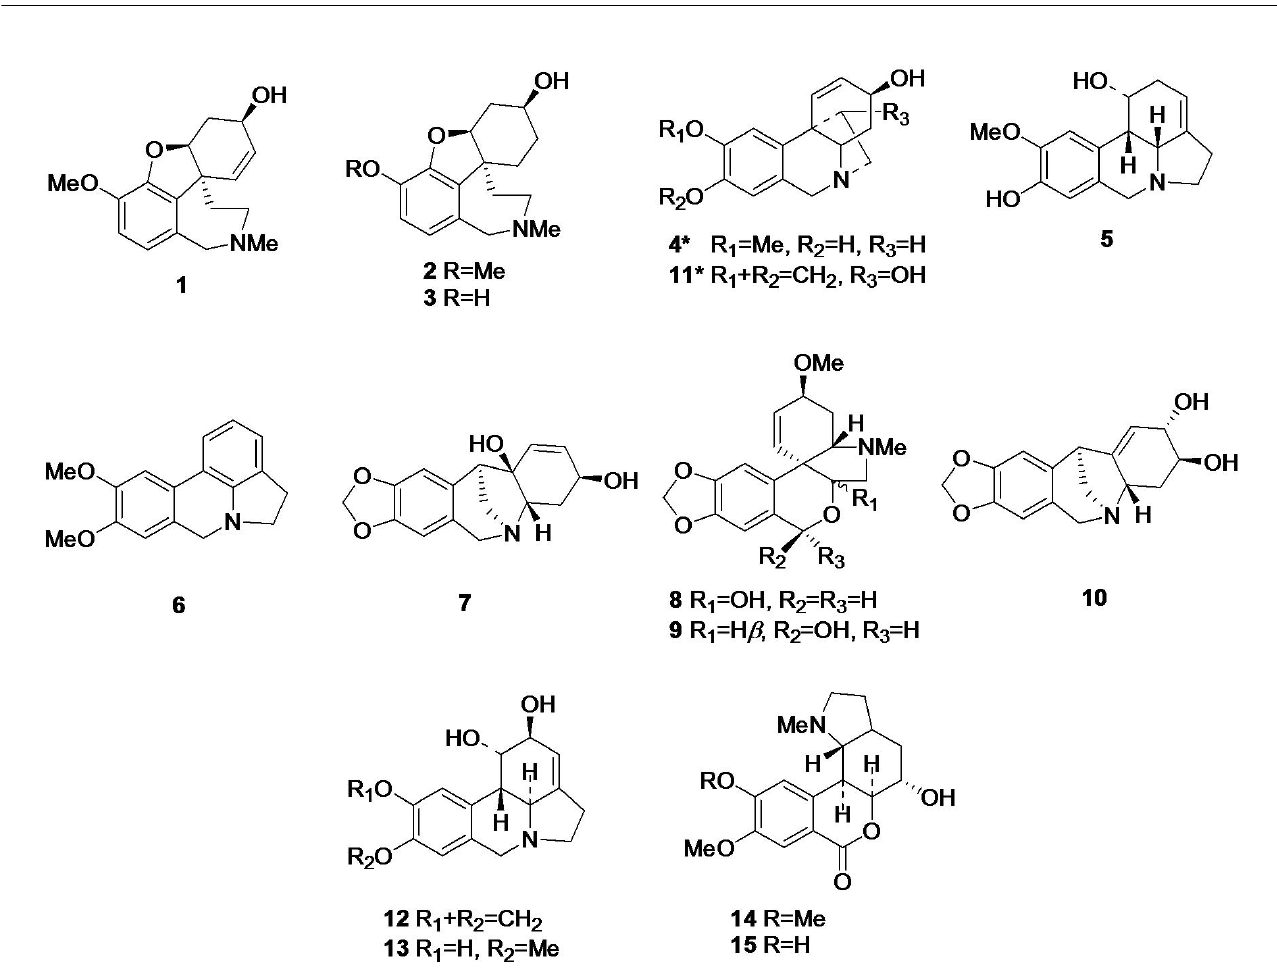
FIGURE 2 – Alkalois identified from Hippeastrum puniceum . * the absolute configuration of compounds 4 and 11 cannot be achieved by